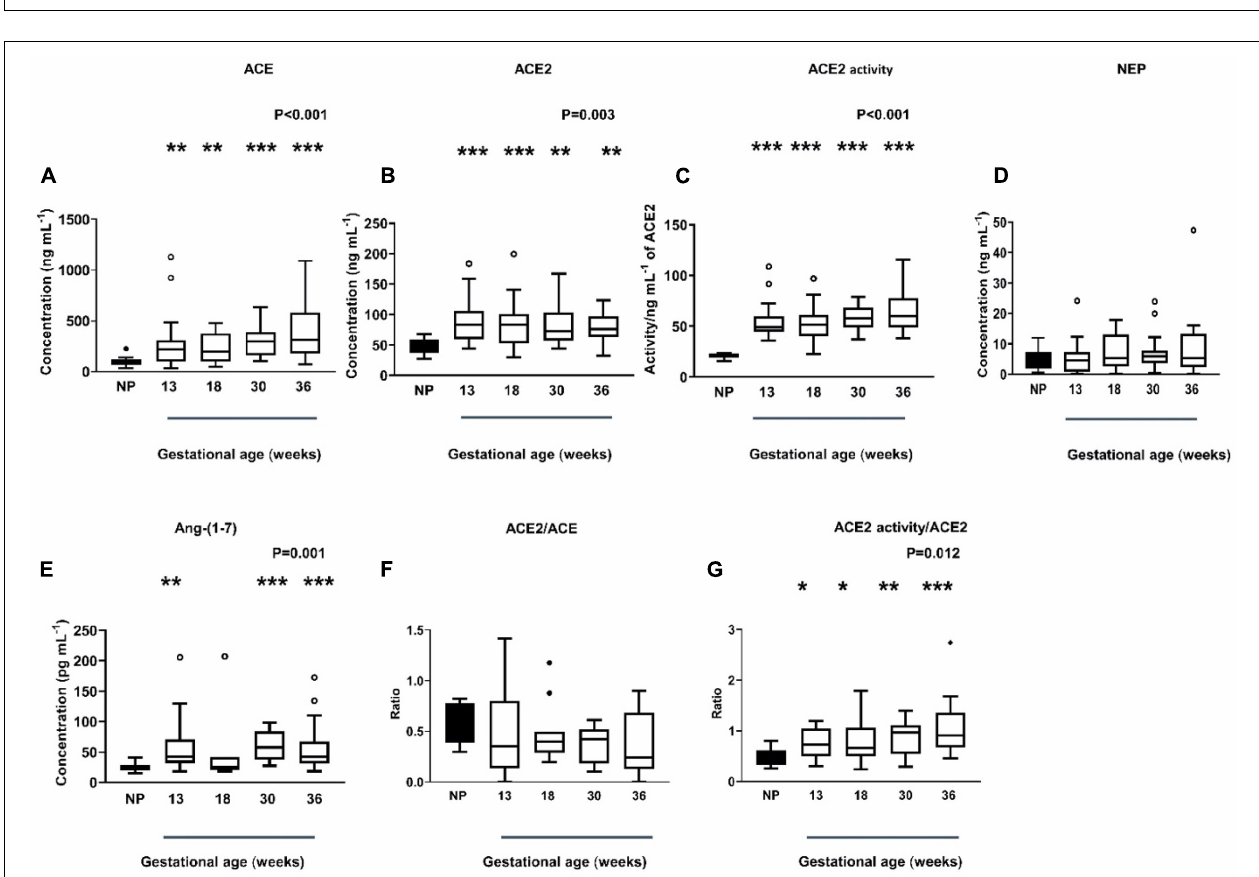
FIGURE 2 | Correlations between (A) ACE2 levels and ACE2 activity (non-pregnant and all pregnancy groups combined), (B) ACE2 levels and Ang-(1-7) levels, and (C) ACE2 activity and Ang-(1-7) levels.